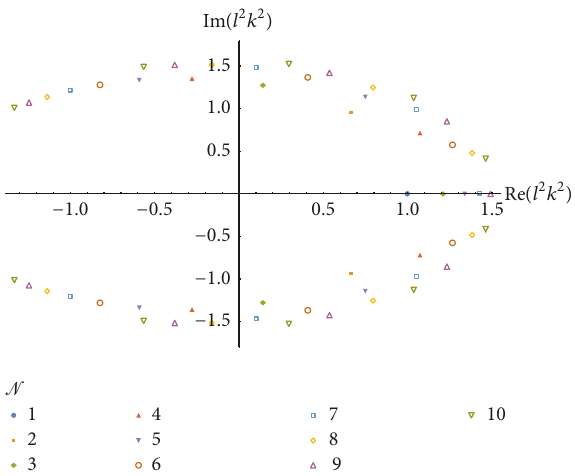
Figure 1: Structure of nontrivial poles of the propagator on the complex